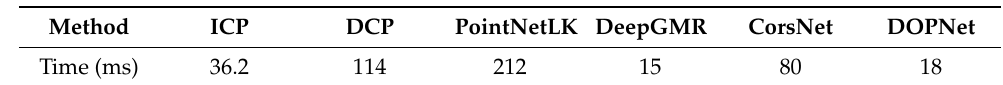
Table 6. Calculation